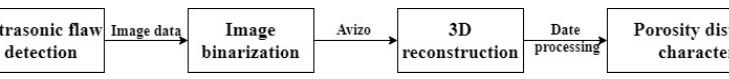
Figure 5. Schematic of ultrasonic flaw detection.